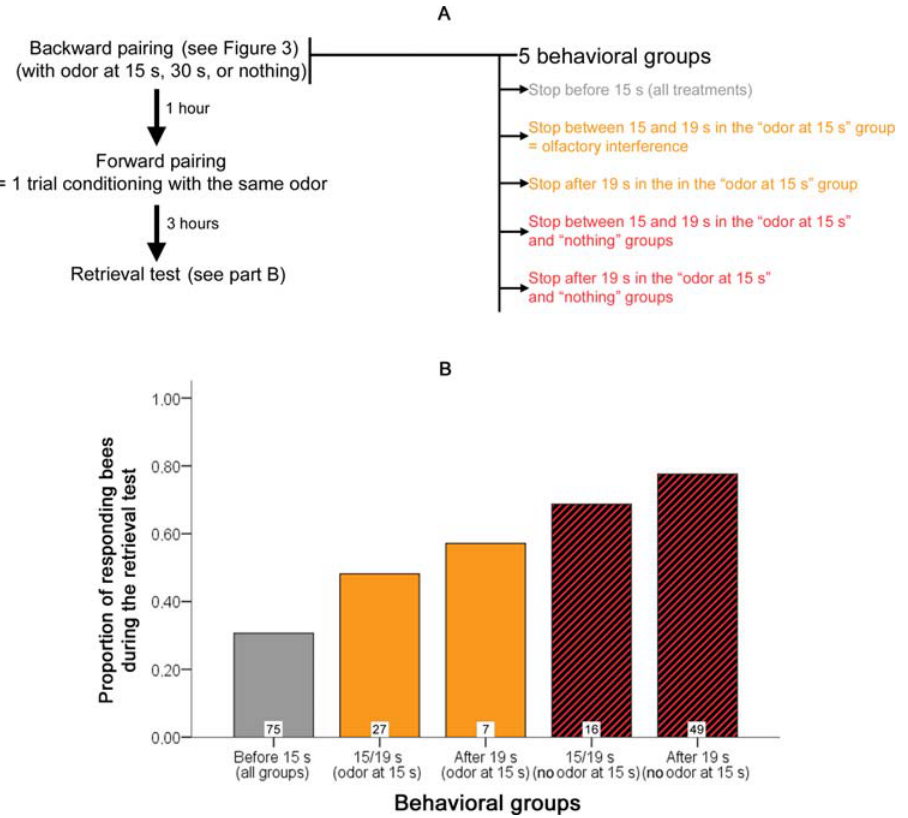
Figure 4. Effect of olfactory interference on a subsequent learning. (A) Details of the protocol used. One hour after the backward pairing, the bees were trained with a single forward pairing, followed by a retrieval test 3 hours after the training. The odor used was either 1-nonanol or octanal. For the 15 s and the 30 s groups, the same odor was used for backward and forward pairing. The animals that were trained in this forward pairing are those of Figure 3 (see this figure to their performance during olfactory interference). Although the same animals were used as in A, the sample size is lower because some bees died or did not respond to the sucrose after backward pairing (the proportion of bees discarded for these reasons was the same across the six groups: 5 degrees of freedom x 2 =1.8624, p=0.868, and the olfactory interference effect was also significant for the remaining bees). After conducting the whole experiment, animals were assigned to one of five behavioral groups according to the time at which they retracted their proboscis during the backward pairing (see details in figure). These five groups are used for the analysis in part B. B: Performance of the bees during the retrieval test, as a function of their behavioral group. The boxes at the base of each bar indicate the sample size. An alternative representation is provided in supplementary Figure S4; this figure also provides a justification for the attribution of the groups in part